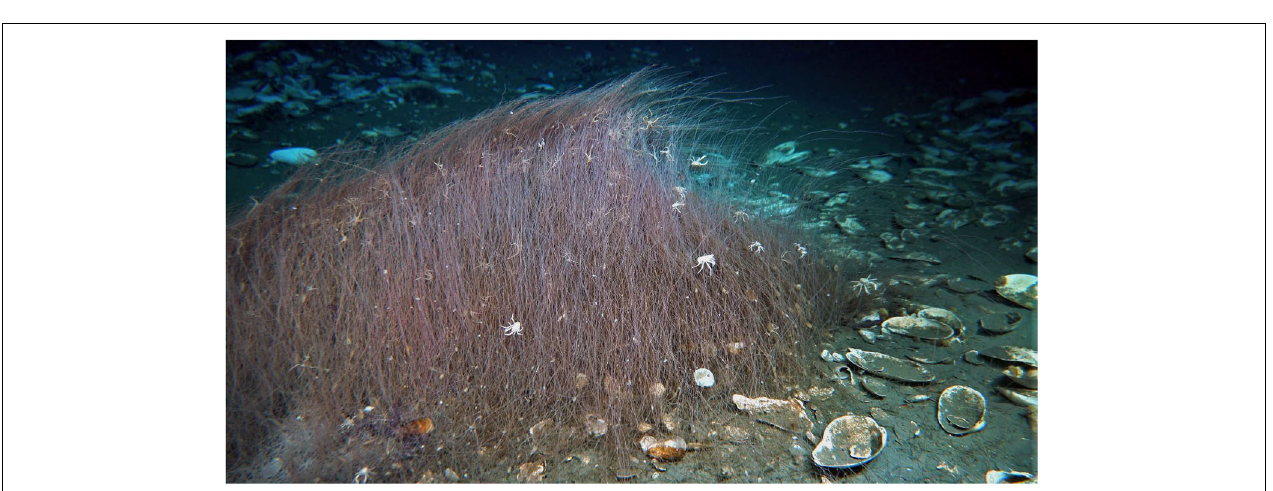
FIGURE 2 | An in situ photograph showing an aggregation of Sclerolinum annulatus n. sp. (rough length × width: 10 m × 3 m) mainly surrounded by numerous empty shells of the vesicomyid clam Archivesica marissinica and a few empty shells of the bathymodioline mussel Gigantidas haimaensis . Many other macrobenthos are also present around this aggregation, such as the squat lobster Munidopsis sp. and the brittle star Ophiophthalmus sp. Photo credit: Dr. Jun Tao from Guangzhou Marine Geological Survey (Guangzhou, China).